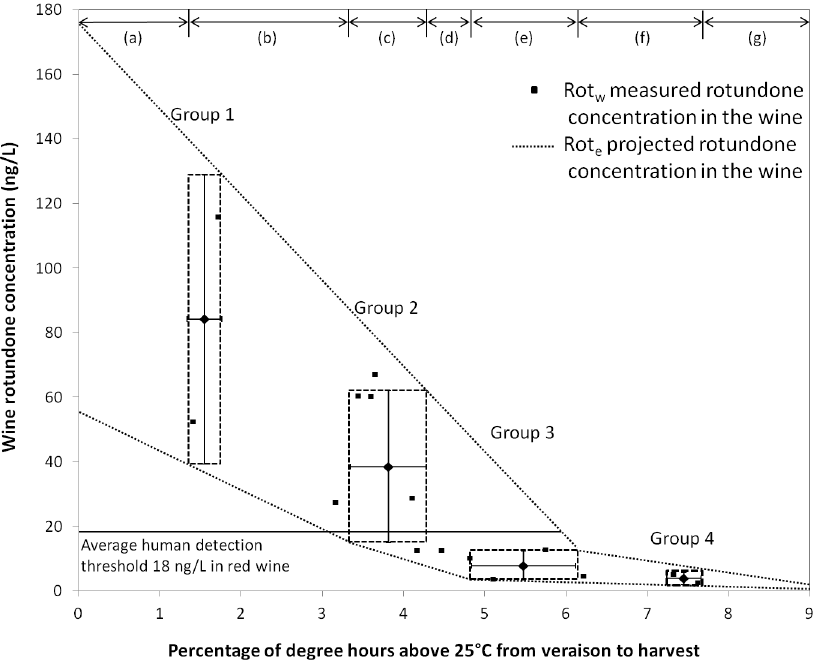
Fig 6. Projection of wine rotundone concentration (Rot e ) range based on the percentage of degree hours above 25°C (DH 25 ) from veraison to harvest. The dot points indicate each studied season. The dash lines connecting each seasonal group indicate the Rot e range at a specific DH 25i , specified in S6